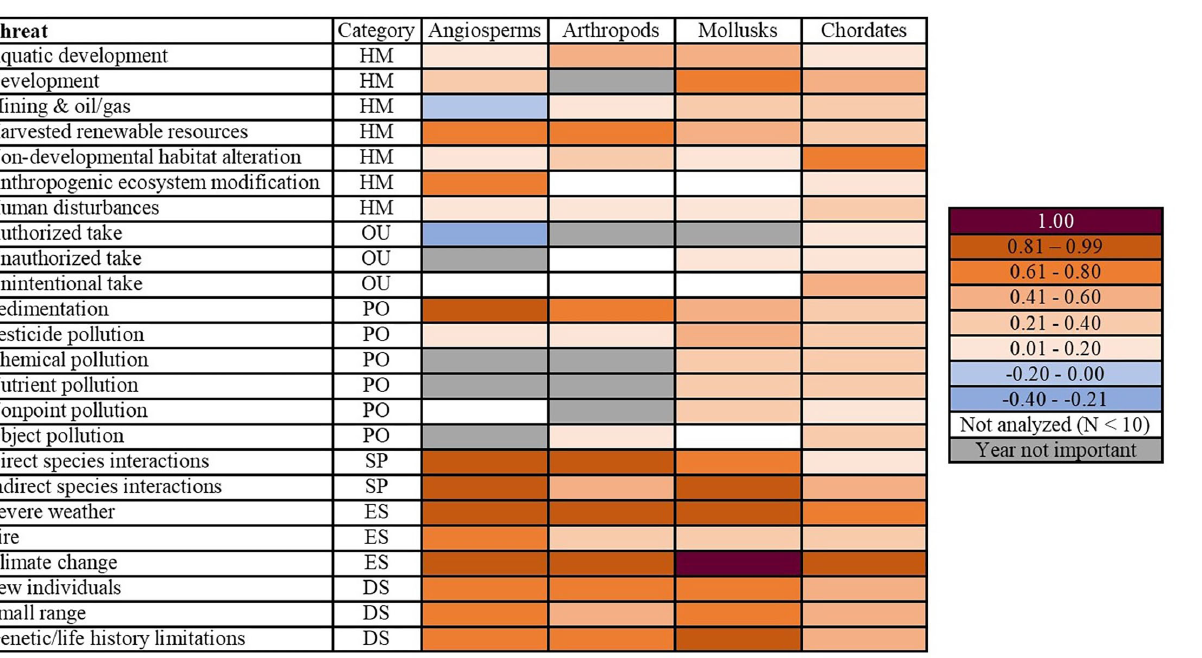
FIGURE 2 | Differences in probabilities of a threat impacting a phylum between their first and most recent years of listing. Angiosperms had both the greatest number of escalating threats (increased by ≥ 0.81) and the only threats which had decreased in probability. Category corresponds to the broad-resolution threats of habitat modification (HM), overutilization (OU), pollution (PO), species interactions (SP), environmental stochasticity (ES), and demographic stochasticity (DS). Year not important denotes that there was no year effect for a particular threat/phyla combination (the null model was the best fit). Not analyzed ( N < 10) is noted for phyla for which a given threat was not analyzed due to insufficient sample size. The 1.00 probability indicates we were unable to model the data because of perfect fit.